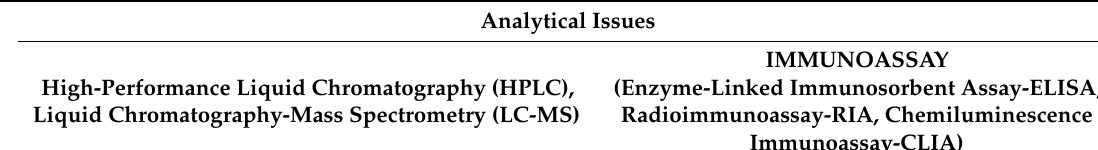
Table 1. Preanalytical and analytical determinants of 25(OH)D